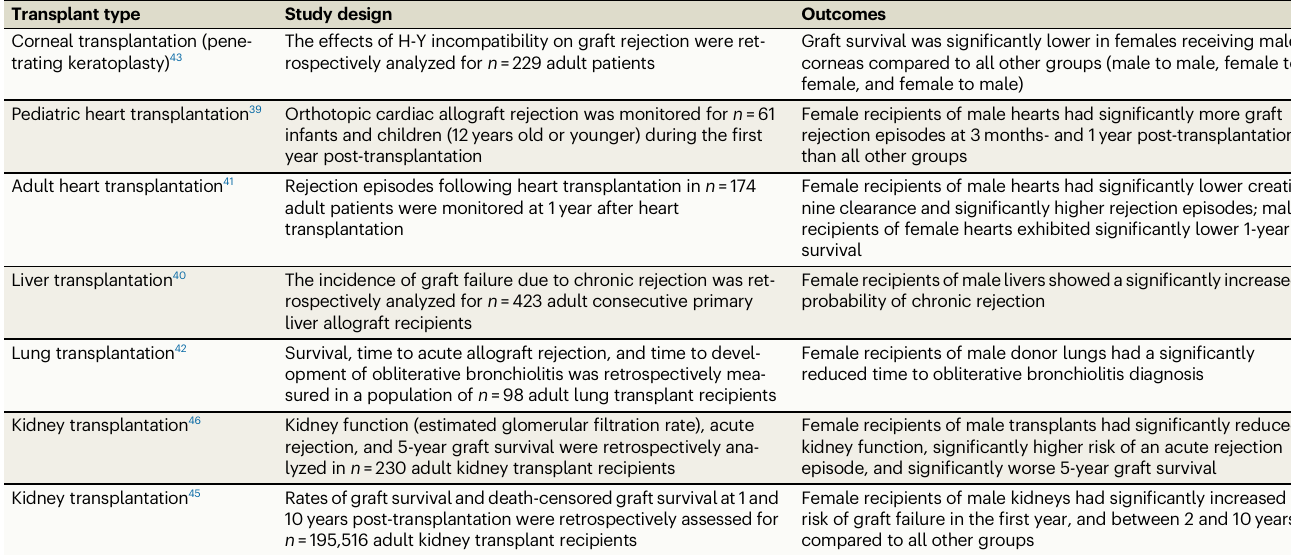
Table 1 | Summary of selected clinical research studies reporting adverse outcomes following transplantation of male donor tissue into female recipients Transplant